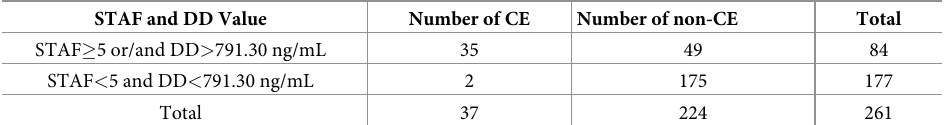
Table 4. Evaluation of STAF and DD in combined diagnosis of CE (parallel diagnostic